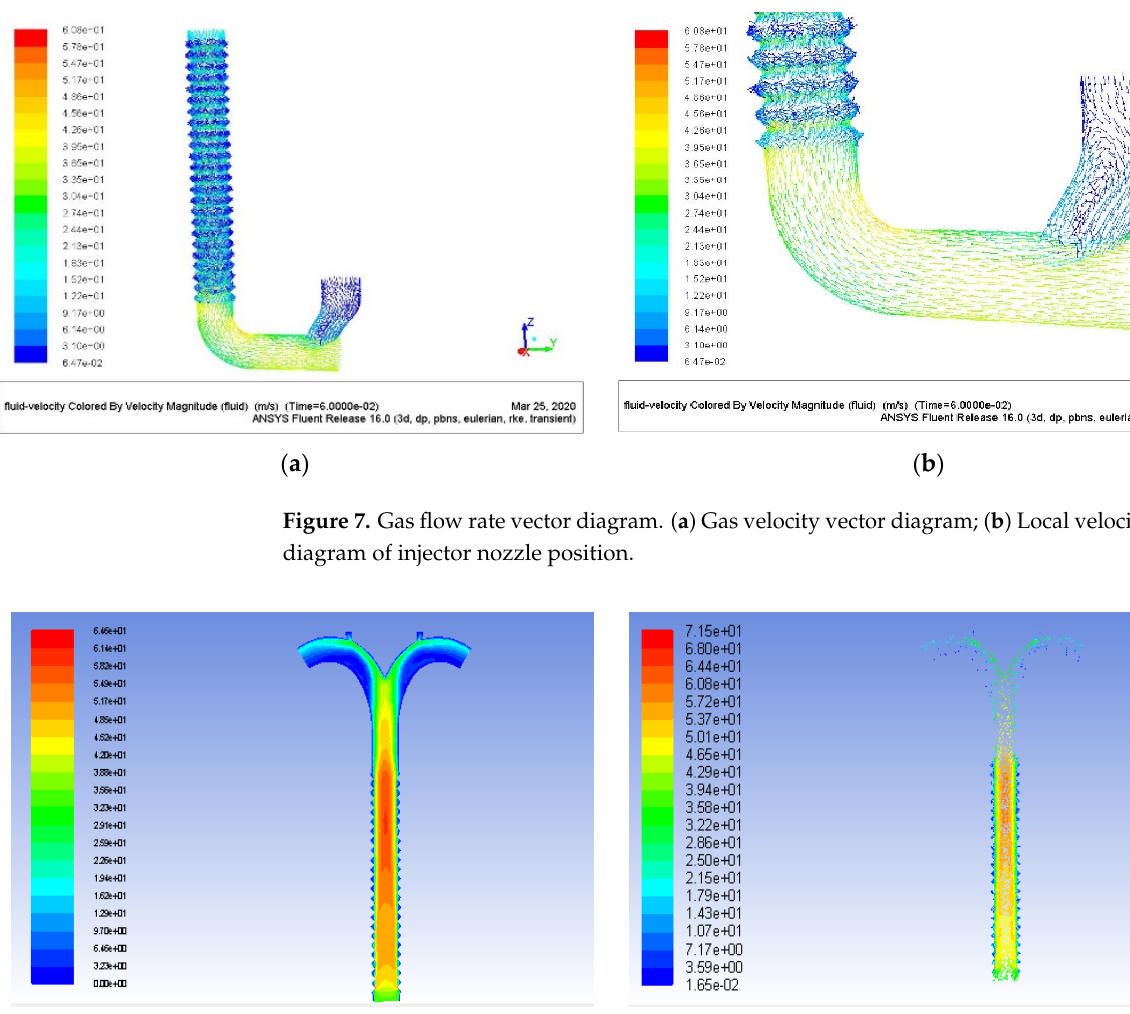
Figure 9. Air flow analysis diagram in conveying pipe ( a ) Local air velocity vector of fertilizer conveying pipe; ( b ) Distribution of local airflow field in fertilizer conveying pipe.